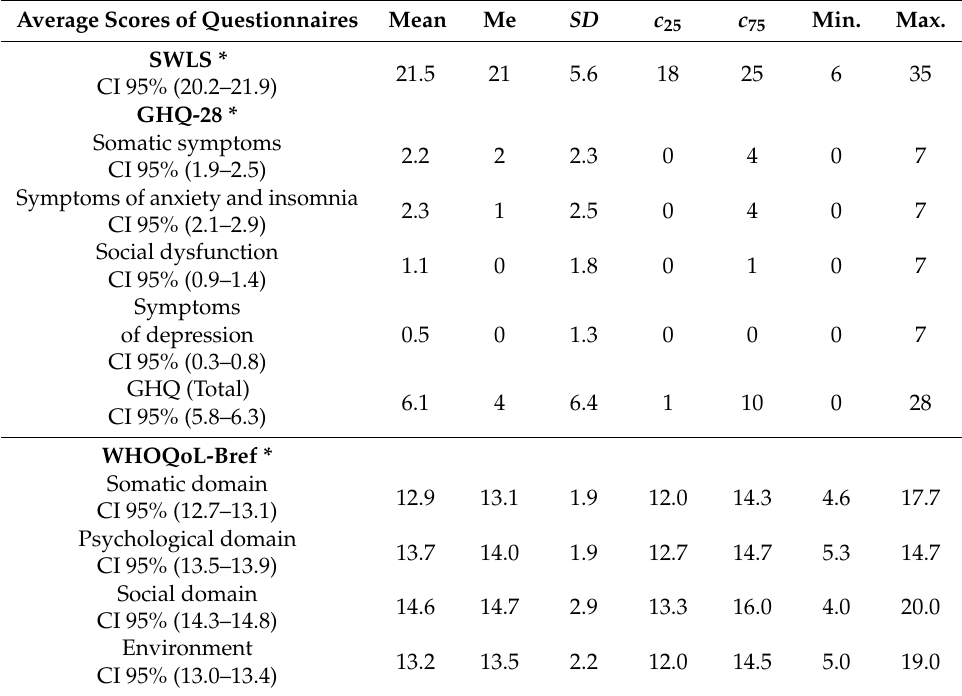
Table 3. Average scores for the SWLS, GHQ-28, and WHOQOL-BREF among respondents.